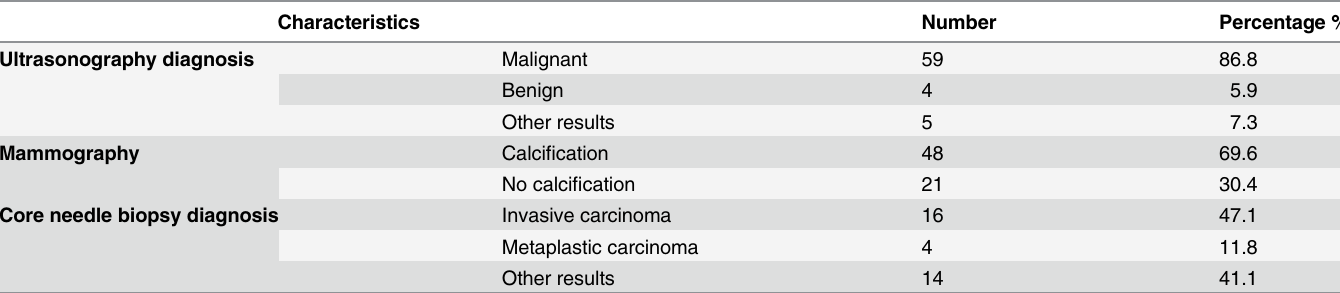
Table 2. Preoperative evaluation of MBC patients.